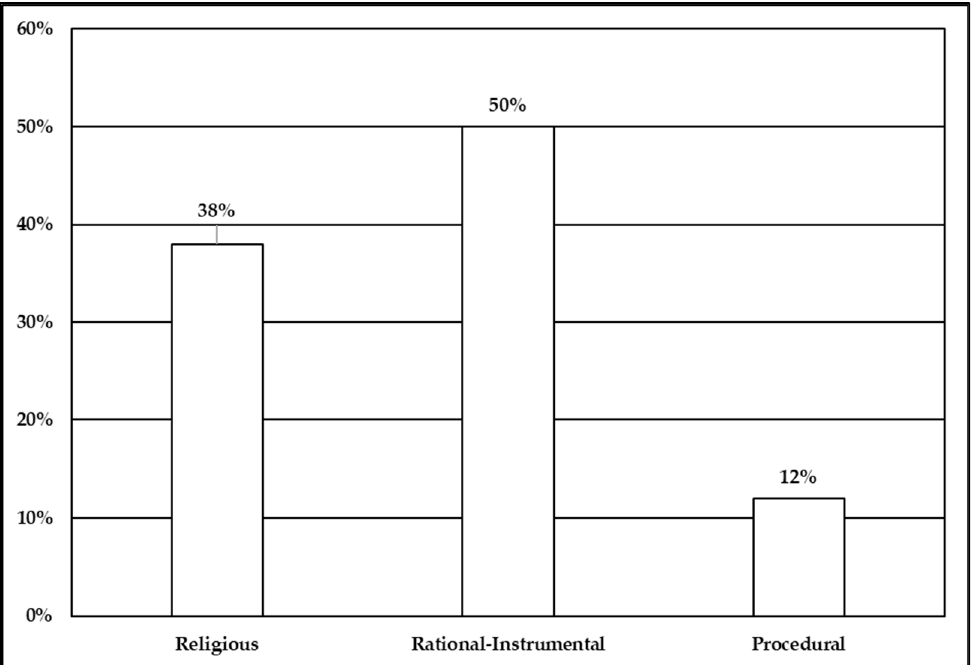
Figure 2. Dominant morality policy frames, percentage (%) of articles where found. Of the articles published on Pravoslavie.Ru, the majority (49 percent) had a rational- instrumental frame, with religious frames taking a close second with 41 percent, and procedural frames with 10 percent. In the case of the Foma.Ru articles, rational-instrumental dominant frames had a greater majority with 65 percent, with religious frames lagging in second at 26 percent, and procedural frames at a mere 9 percent. Articles posted on Pravmir.Ru also showed a clear majority of rational-instrumental dominant frames with 54 percent, followed by religious frames in second with 33 percent, and procedural frames capturing 13 percent. The articles from Ruskline.Ru were the exception, as religious dominant frames led with an overwhelming majority of 80 percent, while procedural frames were in a distant second place with 15 percent, and rational-instrumental frames held 5 percent (see Figure